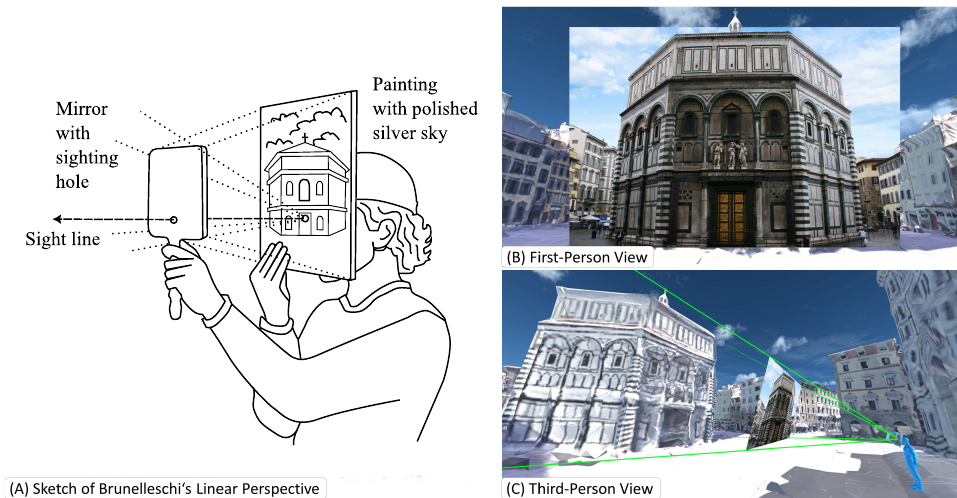
Figure 1. The apparatus of Brunelleschi consists of ( A ) a mirror, and a painted or printed image. Both components inhibit a hole for the user to look through. ( B ) The apparatus creates a linear projec- tion that shows the image inside the user’s view. ( C ) The illustrated third-person view visualizes the frustum that is covered by the projection. Many modern AR applications use the same mathematical basis for creating in situ